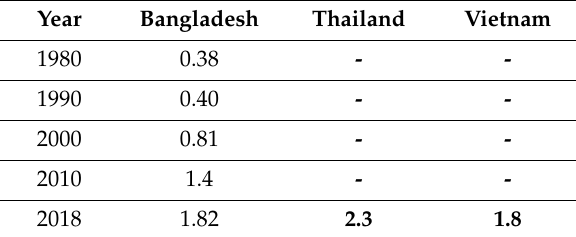
Table 3. Comparative trend of available power used in agriculture (kW / ha).